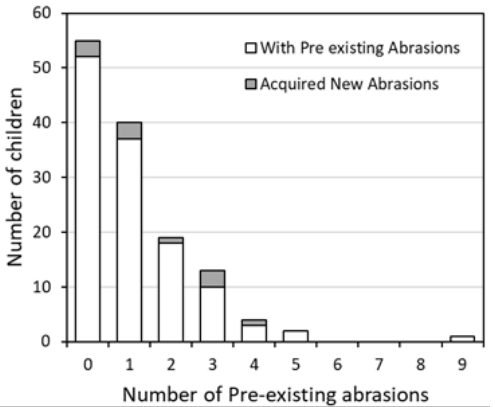
Figure 2. Number of children presenting with pre-existing abrasions compared to the number of children who acquired new abrasions during 1 h of beach play.